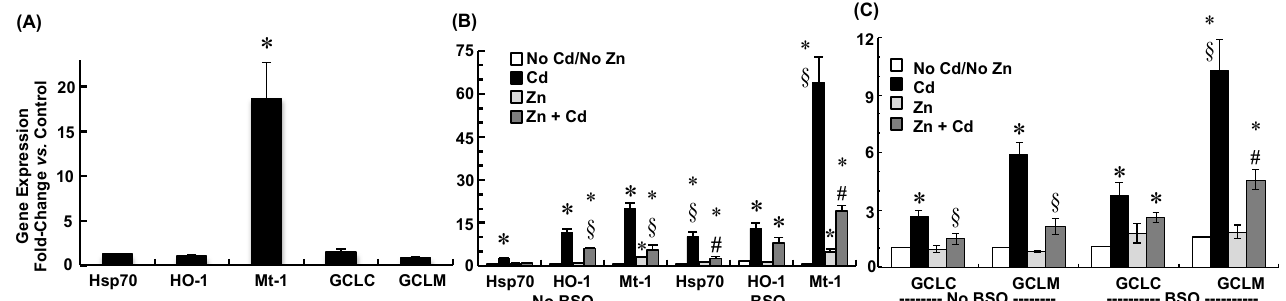
Figure 6. Effects of Zinc supplementation and inhibition of glutathione synthesis by L -buthionine sulfoximine (BSO) on gene expression for rat heat shock protein-70 (Hspa4), heme oxygenase (Hmox1), metallothionein (Mt1), GCLC (Gclc), and GCLM (Gclm) expression in choroid plexus epithelial cells (CPECs) exposed for 12 h to 500 nM CdCl 2 . CPECs were